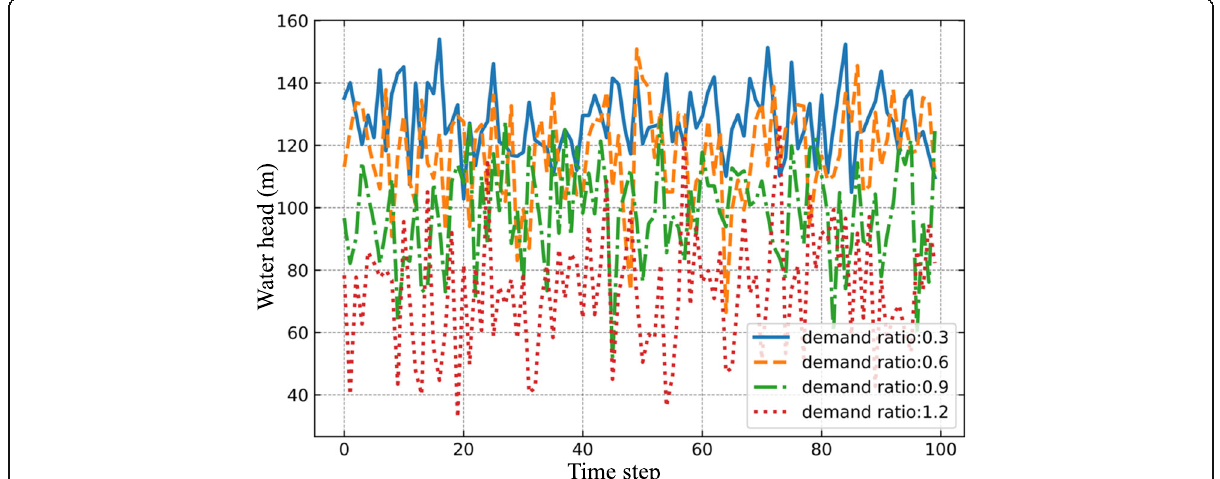
Fig. 5 Example of water head at node ‘ 168 ’ under different water demands (note: demand ratio is defined as the average water demand to the predefined baseline demand at the node (Eq. 11); the fluctuation is due to fluctuations in the real